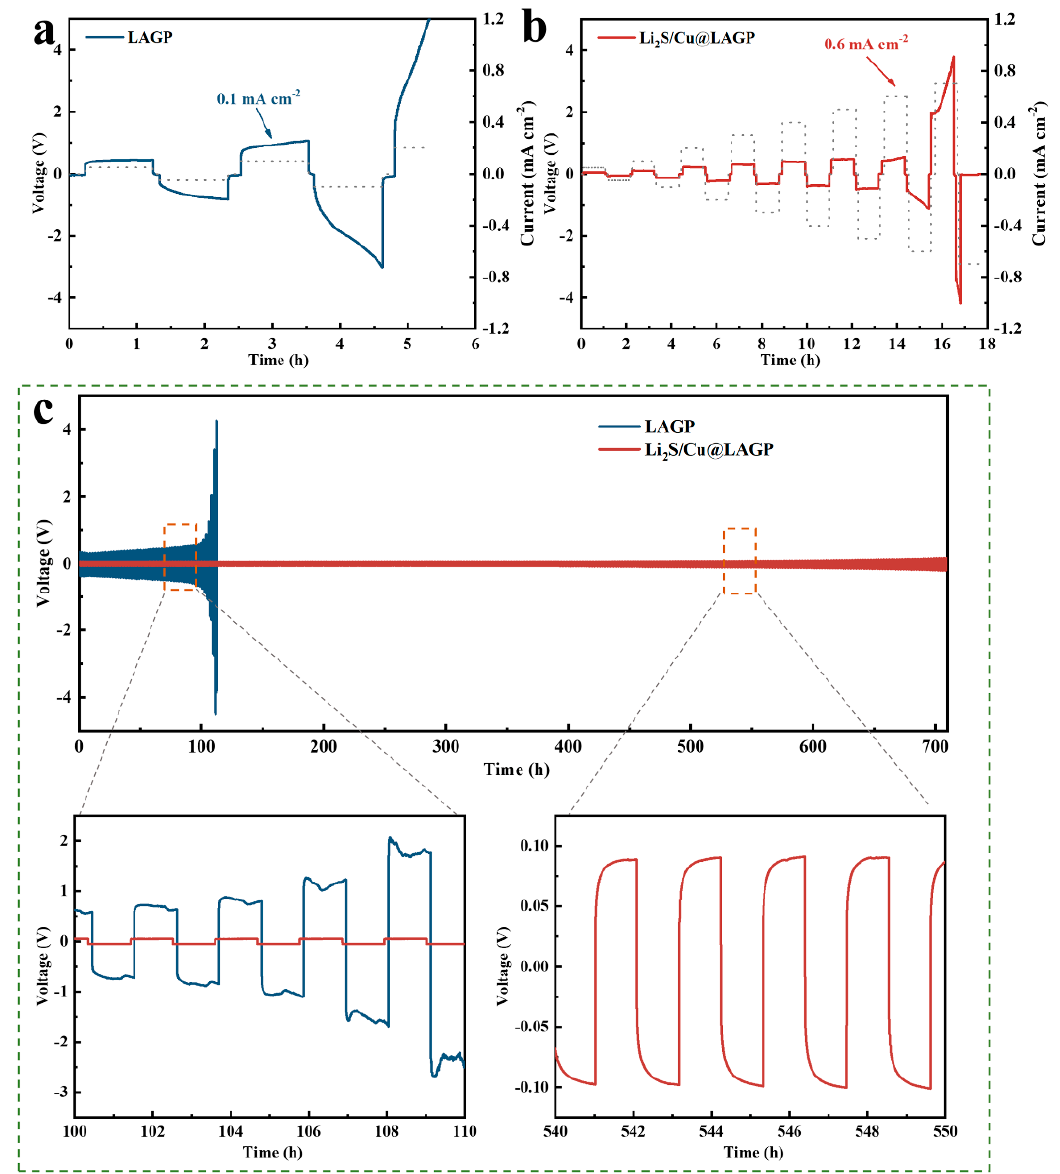
Figure 5. The CCD of the ( a ) pristine LAGP and ( b ) modified Li 2 S/Cu@LAGP symmetric cells. ( c ) Cycling stability performance of pristine LAGP and modified Li 2 S/Cu@LAGP symmetric cells at 0.1 mA cm − 2 and its iconic curves.